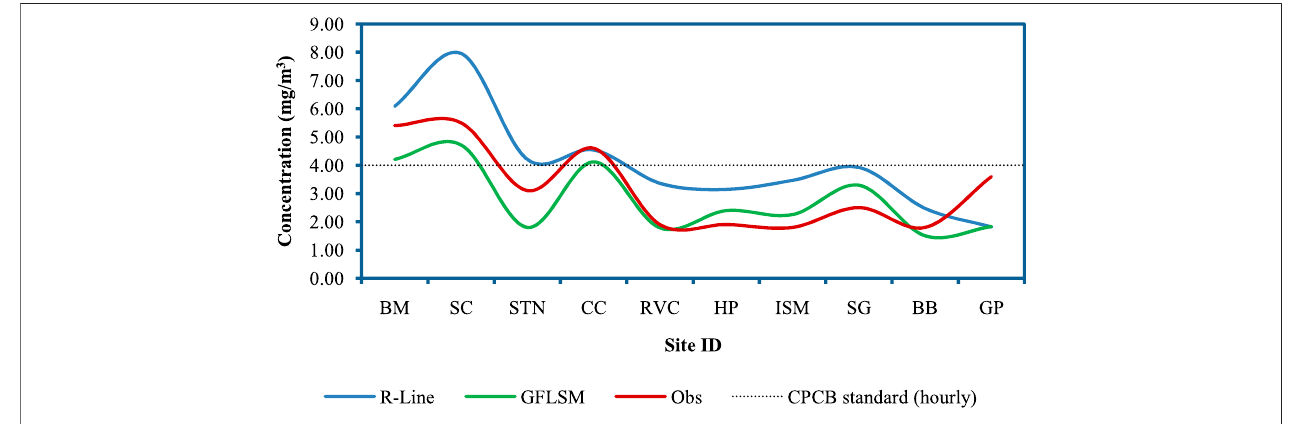
FIGURE 2 | Estimated and observed values of CO concentration in ambient air at different sites of Dhanbad road networks.